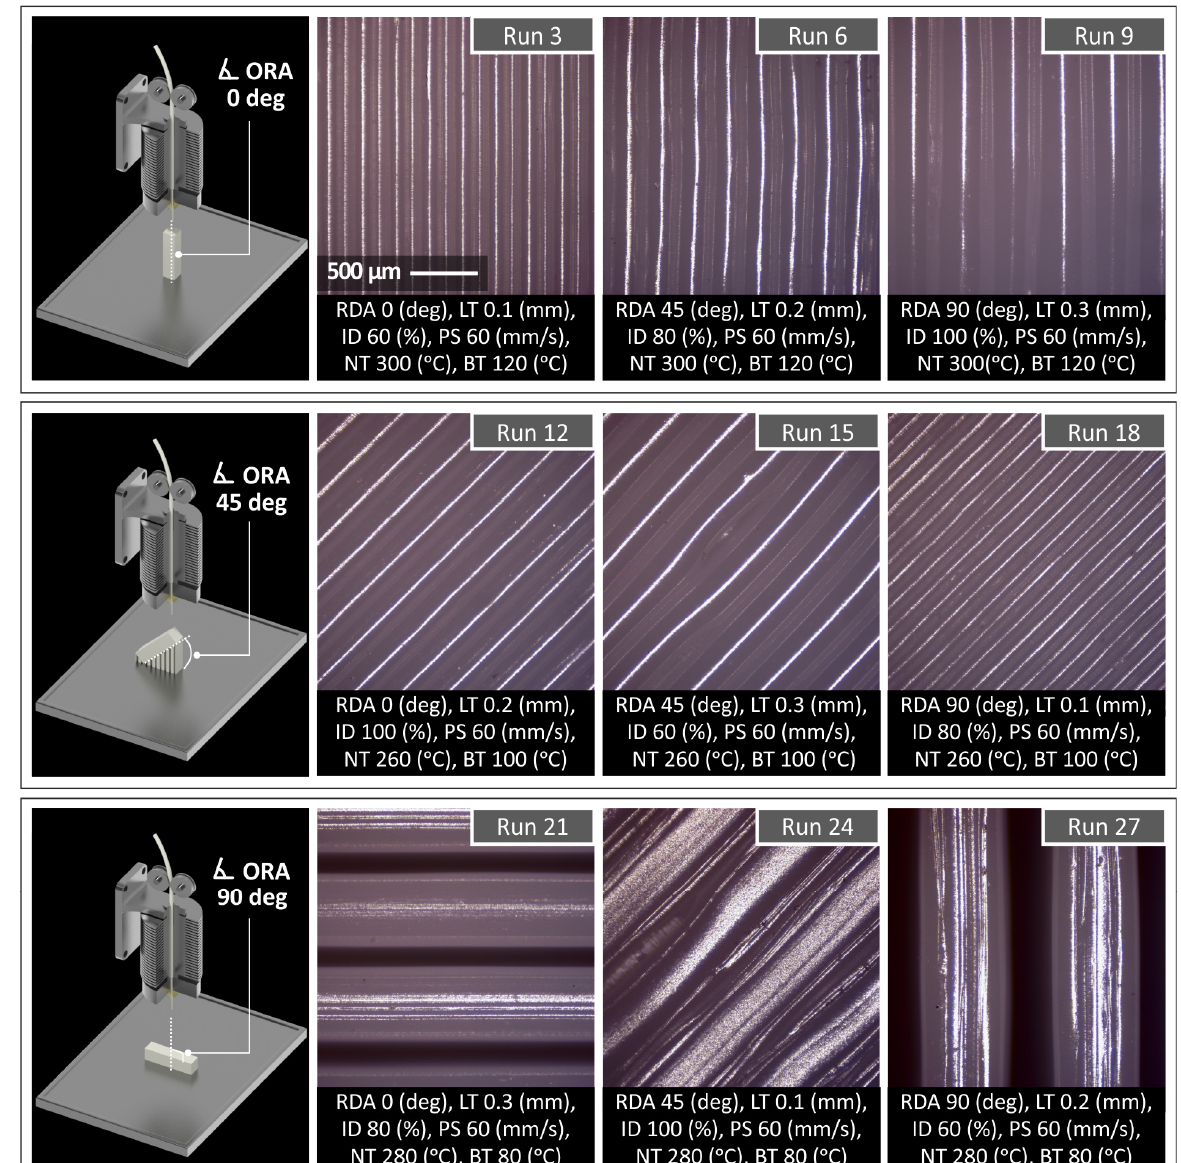
Figure 4. Images from the optical microscope of 3D-printed specimens, built with the various settings studied in this work. The 3D printing orientation angle that each sample was built on is presented on the left side in each case.